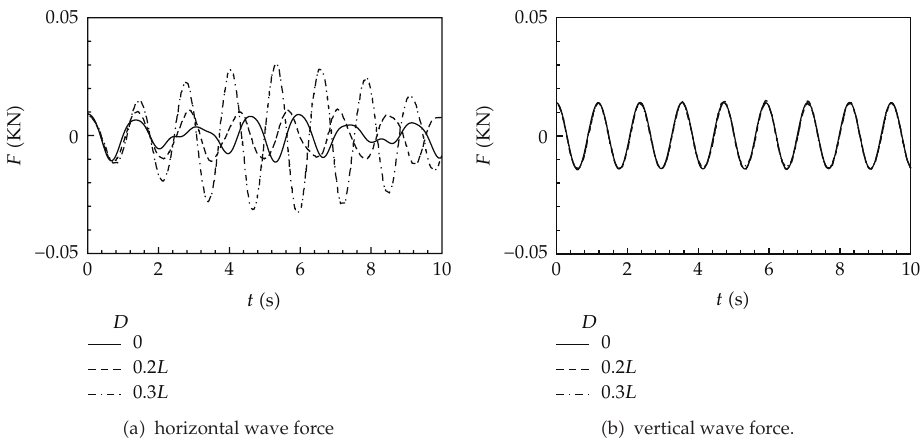
Figure 16: Time histories of total horizontal and vertical wave forces for Hb (cid:8) 0 . 8